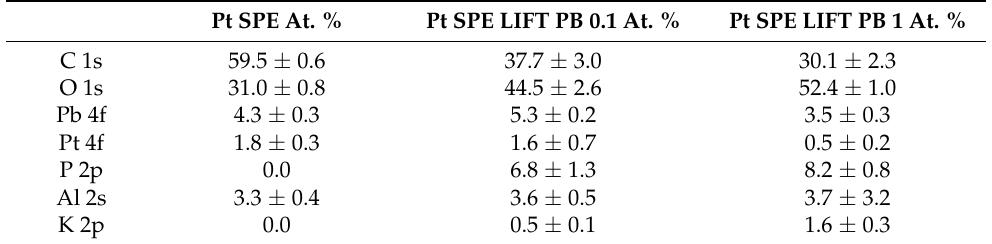
Table 1. Atomic composition of untreated Pt SPE and after LIFT with 0.1 M and 1 M phosphate buffer. Pt SPE At. % Pt SPE LIFT PB 0.1 At.